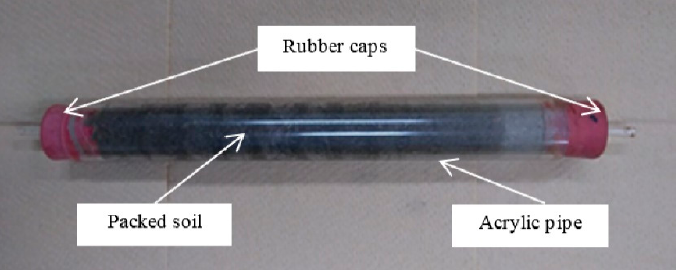
Figure 6. Soil packed into an acrylic pipe for measurement of gas permeability (6.38 cm 2 cross-section, 21.8 cm length).